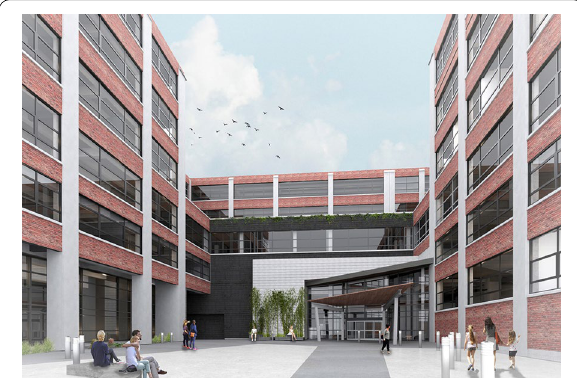
Fig. 11 Trico Plant No 1. redevelopment. Buffalo, New York (Courtesy: The Krog